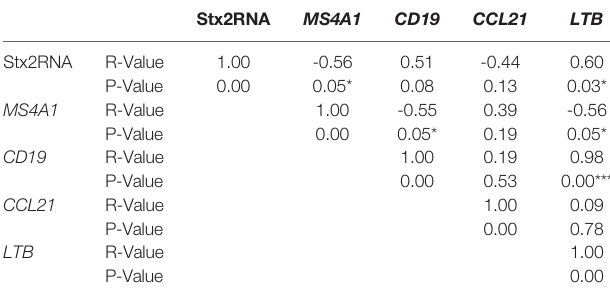
R-valuewasde fi nedasthecorrelationcoef fi cientrangedfrom-1to1.Forcorrelationswith different genes, P-values were included along with the level of statistical signi fi cance (P ≤ 0.05*, P ≤